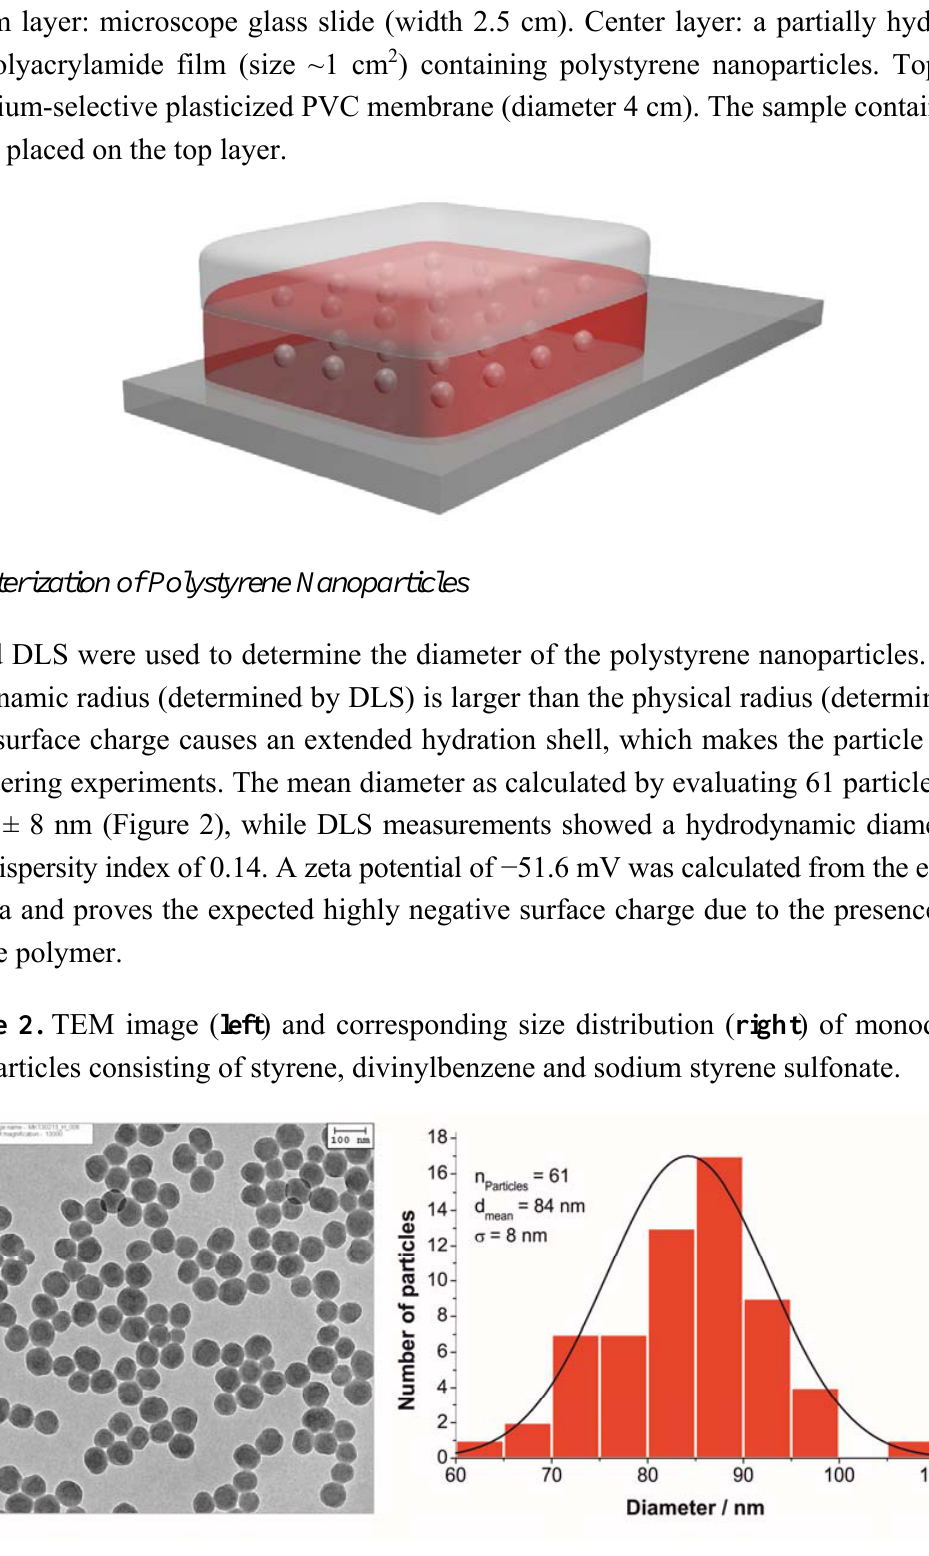
Figure 1. Cross-section of the photonic crystal (PhC)-based sensor for potassium ions. Bottom layer: microscope glass slide (width 2.5 cm). Center layer: a partially hydrolyzed wet polyacrylamide film (size ~1 cm 2 ) containing polystyrene nanoparticles. Top layer: